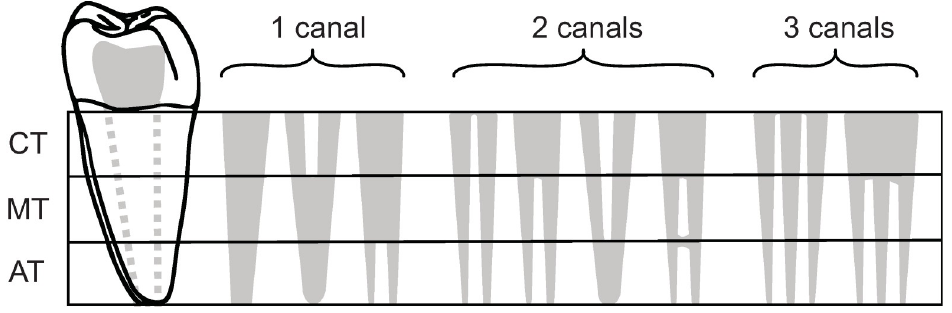
Fig 10. Canal counts and degrees of separation. Solid grey = root canal forms. CT = cervical third, MT = middle third, AT = apical third.